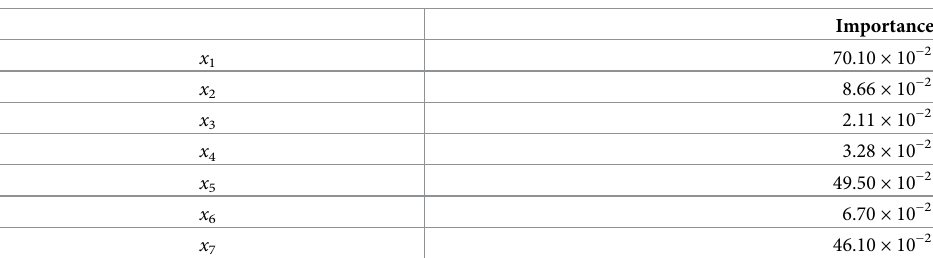
Table 8. Importance of variables.